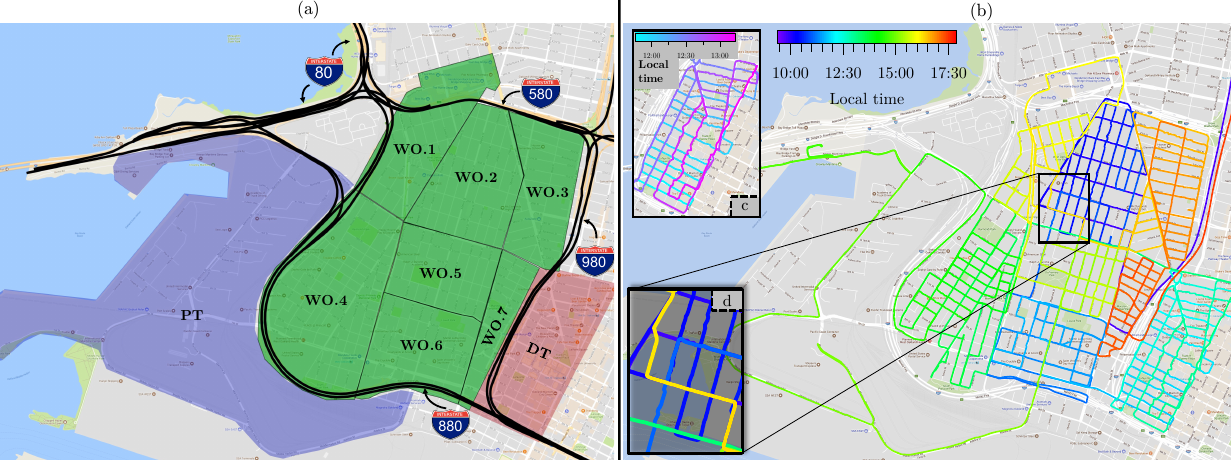
Figure 1. (a) Sampling domain with three major areas: PT (port), WO (West Oakland), and DT (downtown). The seven internal West Oakland polygons are enumerated. (b) Driving route on a typical day, showing the shuffled order of polygon visits. (c) The typical driving route in downtown. (d) A zoom-in illustrating a typical repeat sampling on the same day during inter-polygon